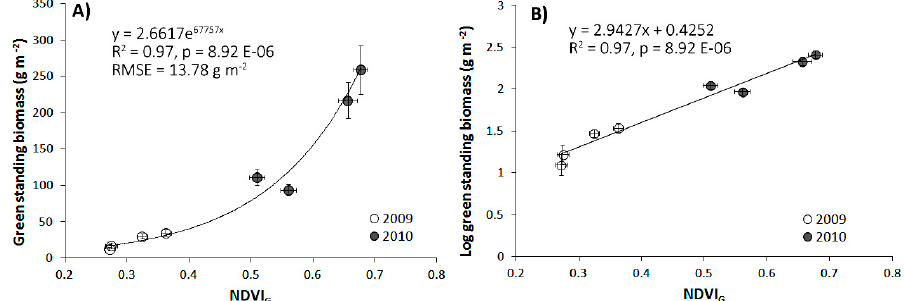
Figure 7. Relationships between peak (July) NDVI G and peak (July) green standing biomass for the combined Sounding Creek and Pinhorn grazing reserves in 2009 and 2010 ( A ); Also shown is the effect of log transformation on the form of the relationship ( B ). Data have been aggregated to the township level by averaging 10 sites per township. Error bars denote standard error of the mean.